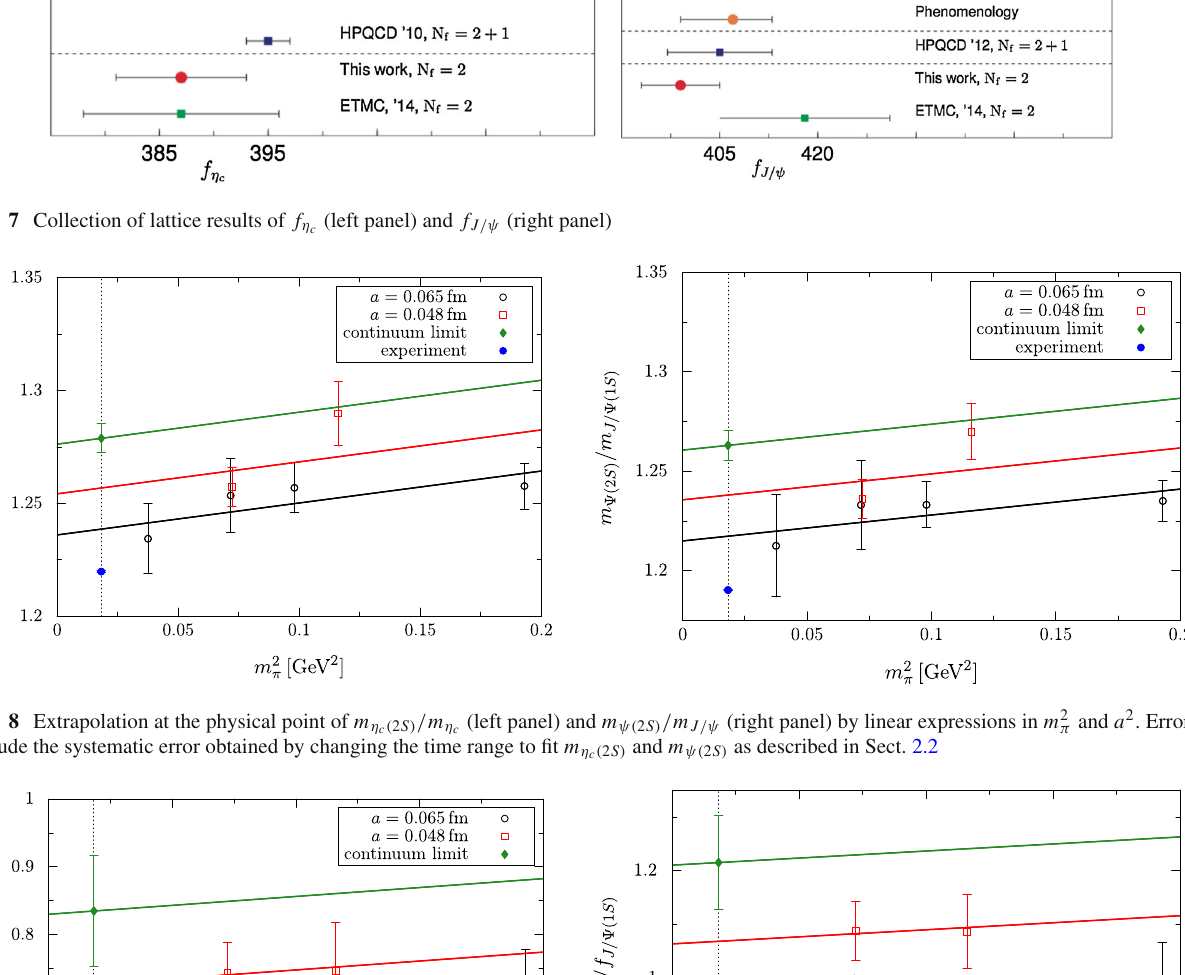
Fig. 7 Collection of lattice results of f η